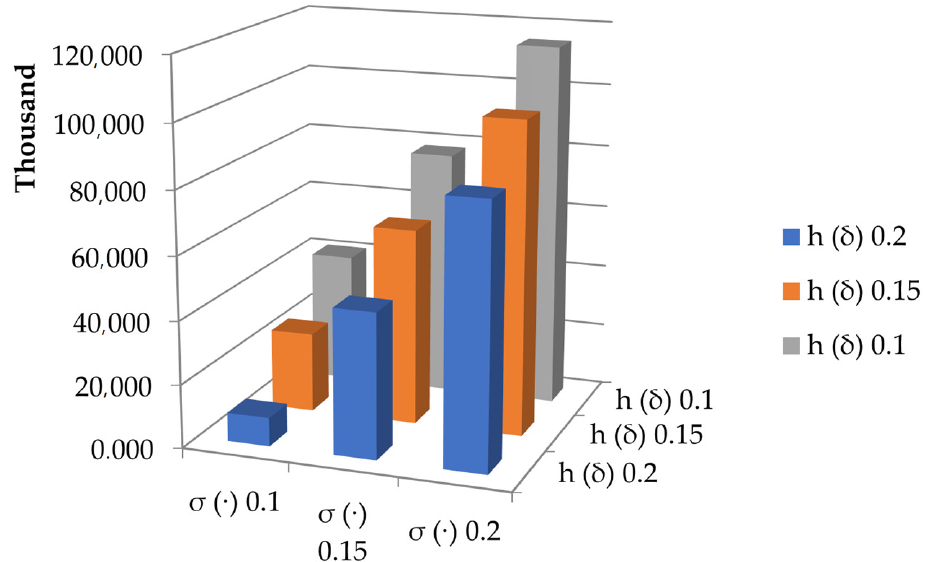
Figure 4. The Subordinate’s objective function using B.I.M. with different Principal’s control parame- ters of the stimulation and loss functions.